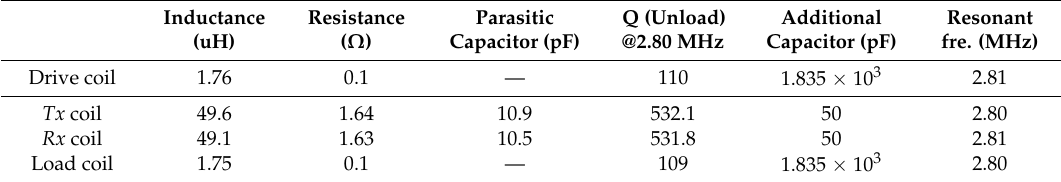
Figure 11. Experiment setup of the WPT system with the MM slab. Table 3. The electrical parameters of the four